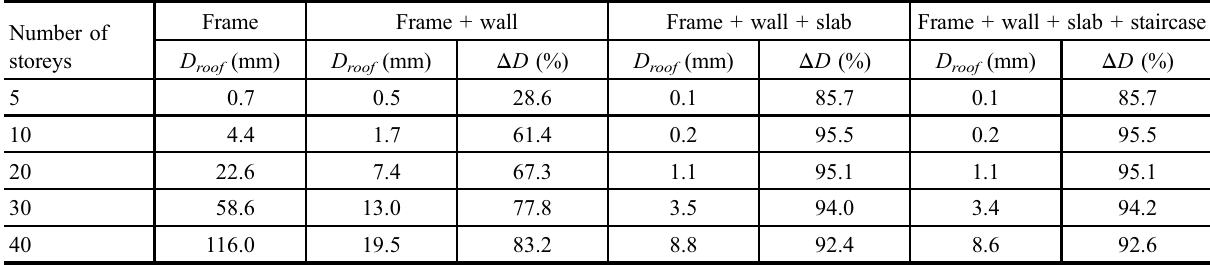
Table 5. Comparison of frequency considering staircase (second higher mode shape) Number